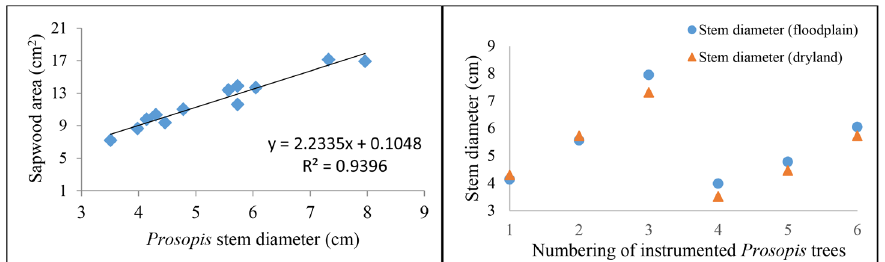
Figure 3. Allometric relationship between sapwood area and stem diameter of the sampled Prosopis trees (left) and stem diameter distributions of instrumented trees (right). [Note: tree numbers 1–3 were from the first batch experimental sites, and trees 4–6 were replications of experimental sites for both habitat types, i.e., floodplains and dryland sites].